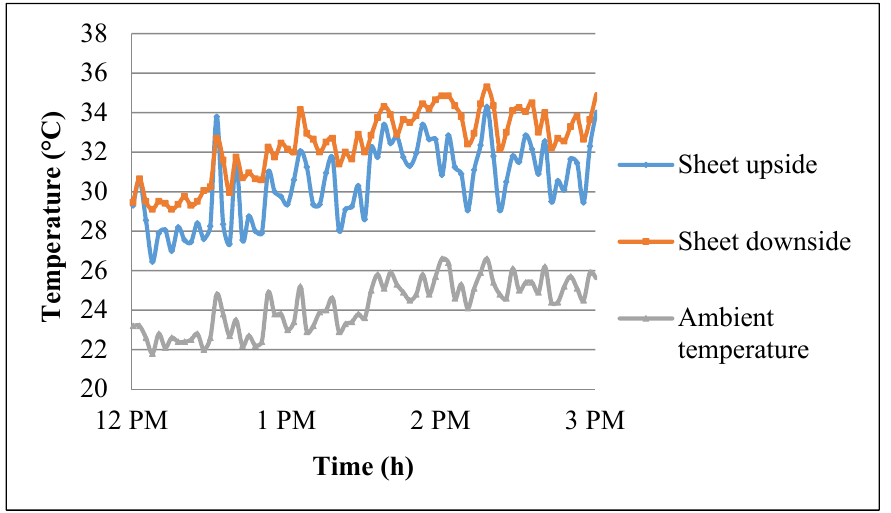
Figure 3. Time dependencies of roof sheet temperature and ambient temperature for model cowshed without installation of PV module.